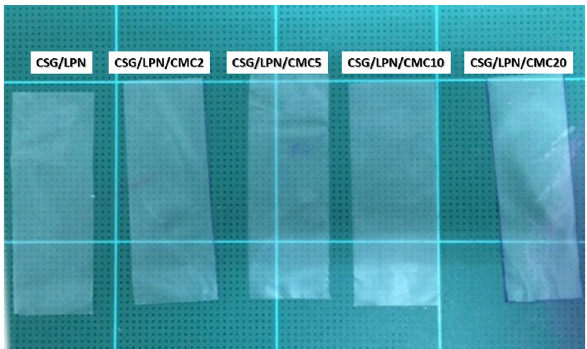
Figure 1. Image of CSG/LNR films blending with CMC 0, 2, 5, 10, 20